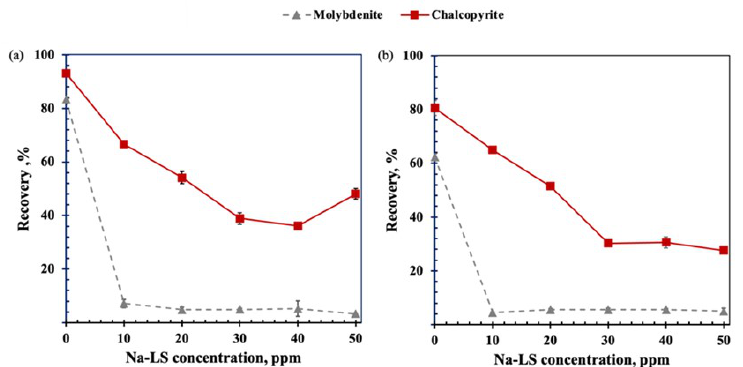
Figure 3. Depressant effect of Na-LS on molybdenite and chalcopyrite in ( a ) freshwater (0.01M NaCl) and ( b ) seawater, using 15 ppm MIBC and 25 ppm PAX as chalcopyrite collector at pH 8.